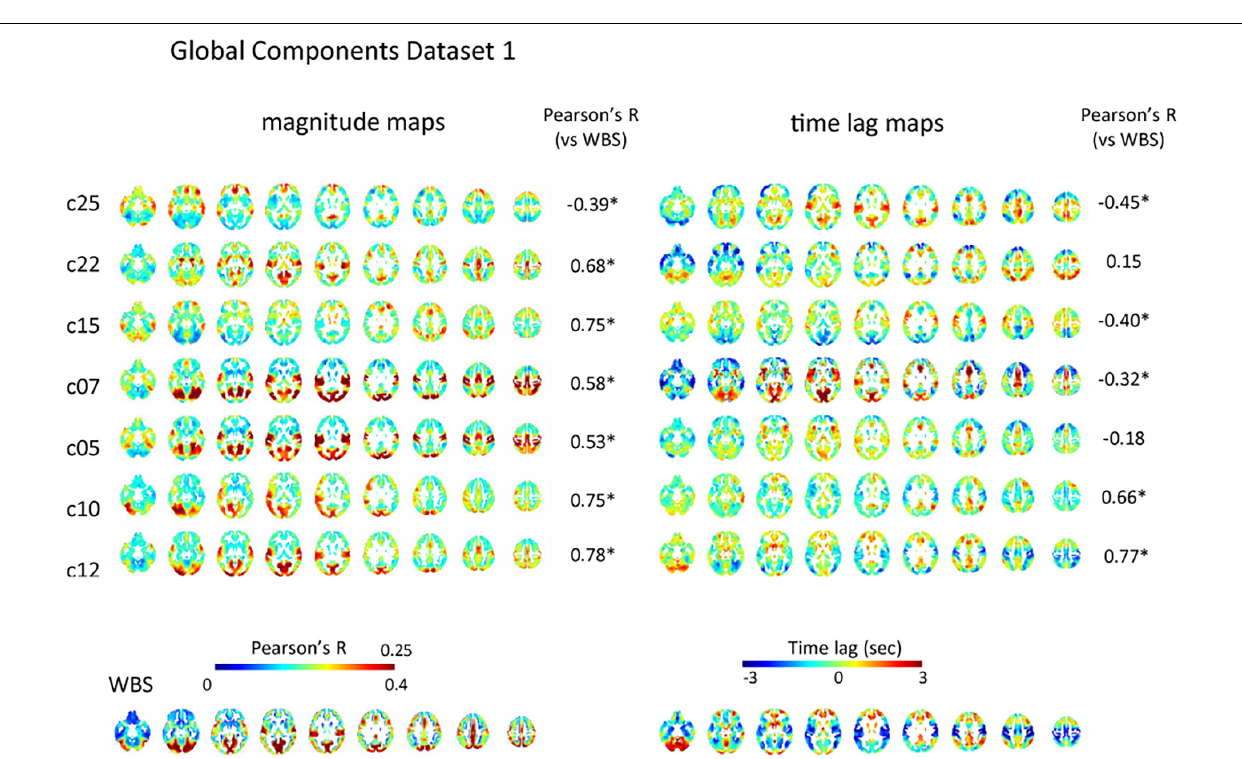
dataset as well as c22 and c26 of the re-test dataset show cerebral